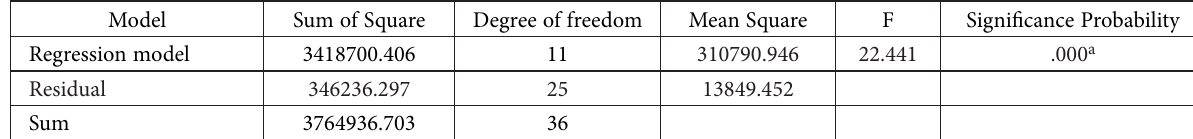
Table 8. Multiple linear regression analysis using the input method – variance analysis